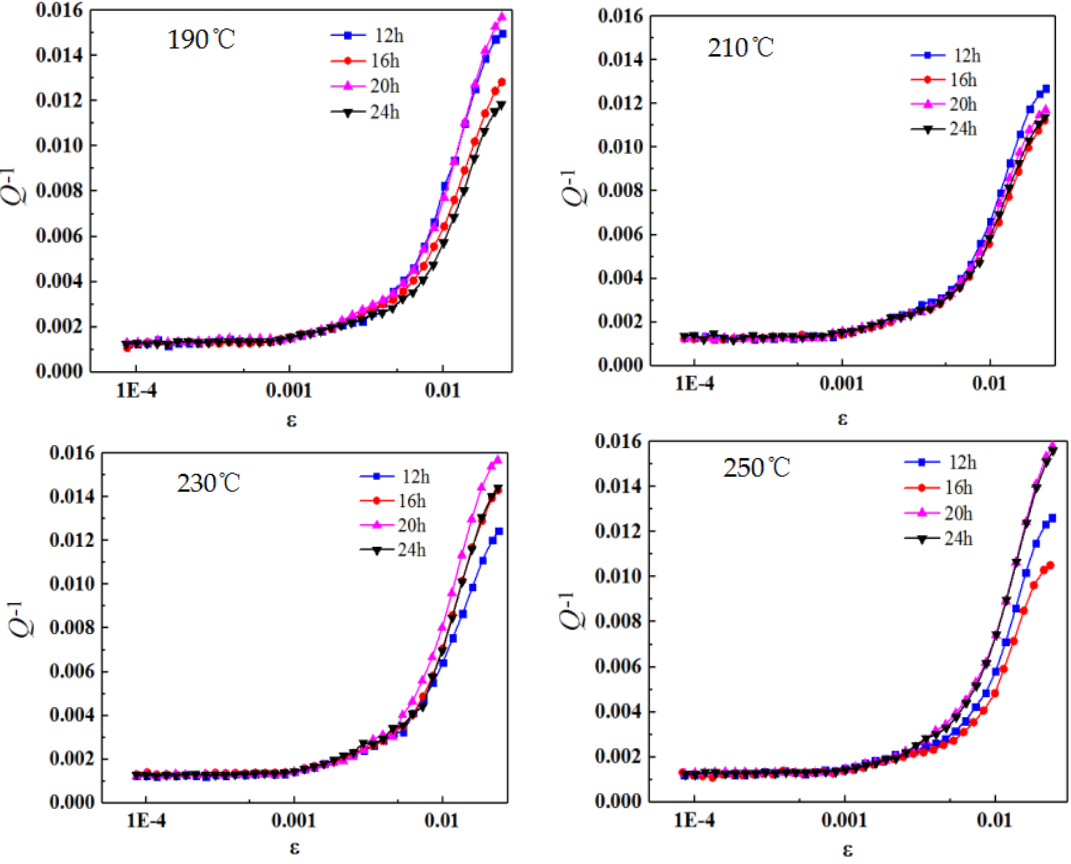
Figure 5. Damping–strain curves under different ageing treatments.